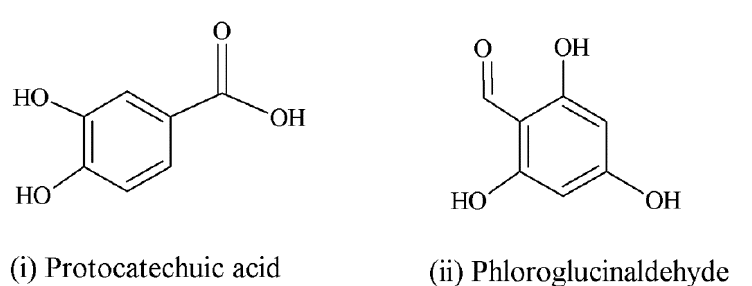
Figure 3. Degradation products of anthocyanins. (i) Protocatechuic acid; (ii)